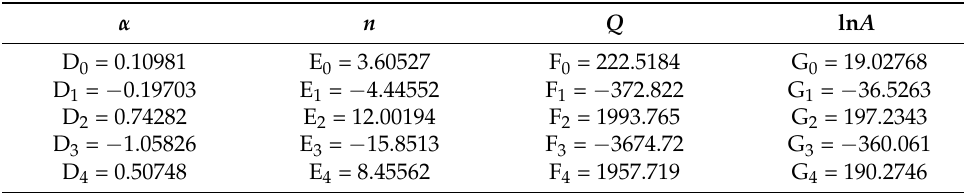
Table 4. Parameters of α , n, Q, and ln A at different strains in the β phase region. α n Q ln A D 0 = 0.10981 E 0 =